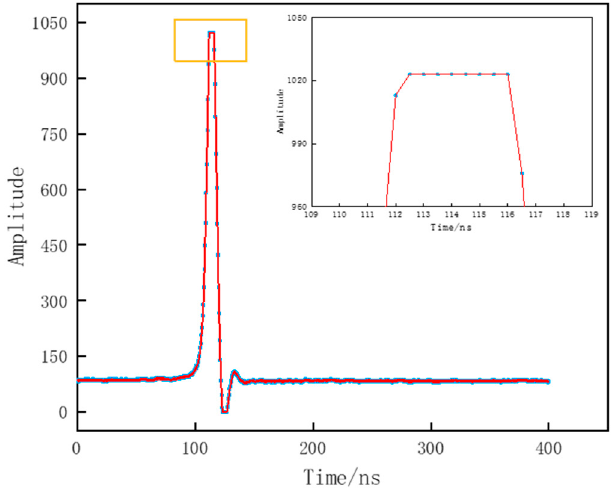
Figure 3. GF-7 space-borne laser altimeter echo data (flat peak).